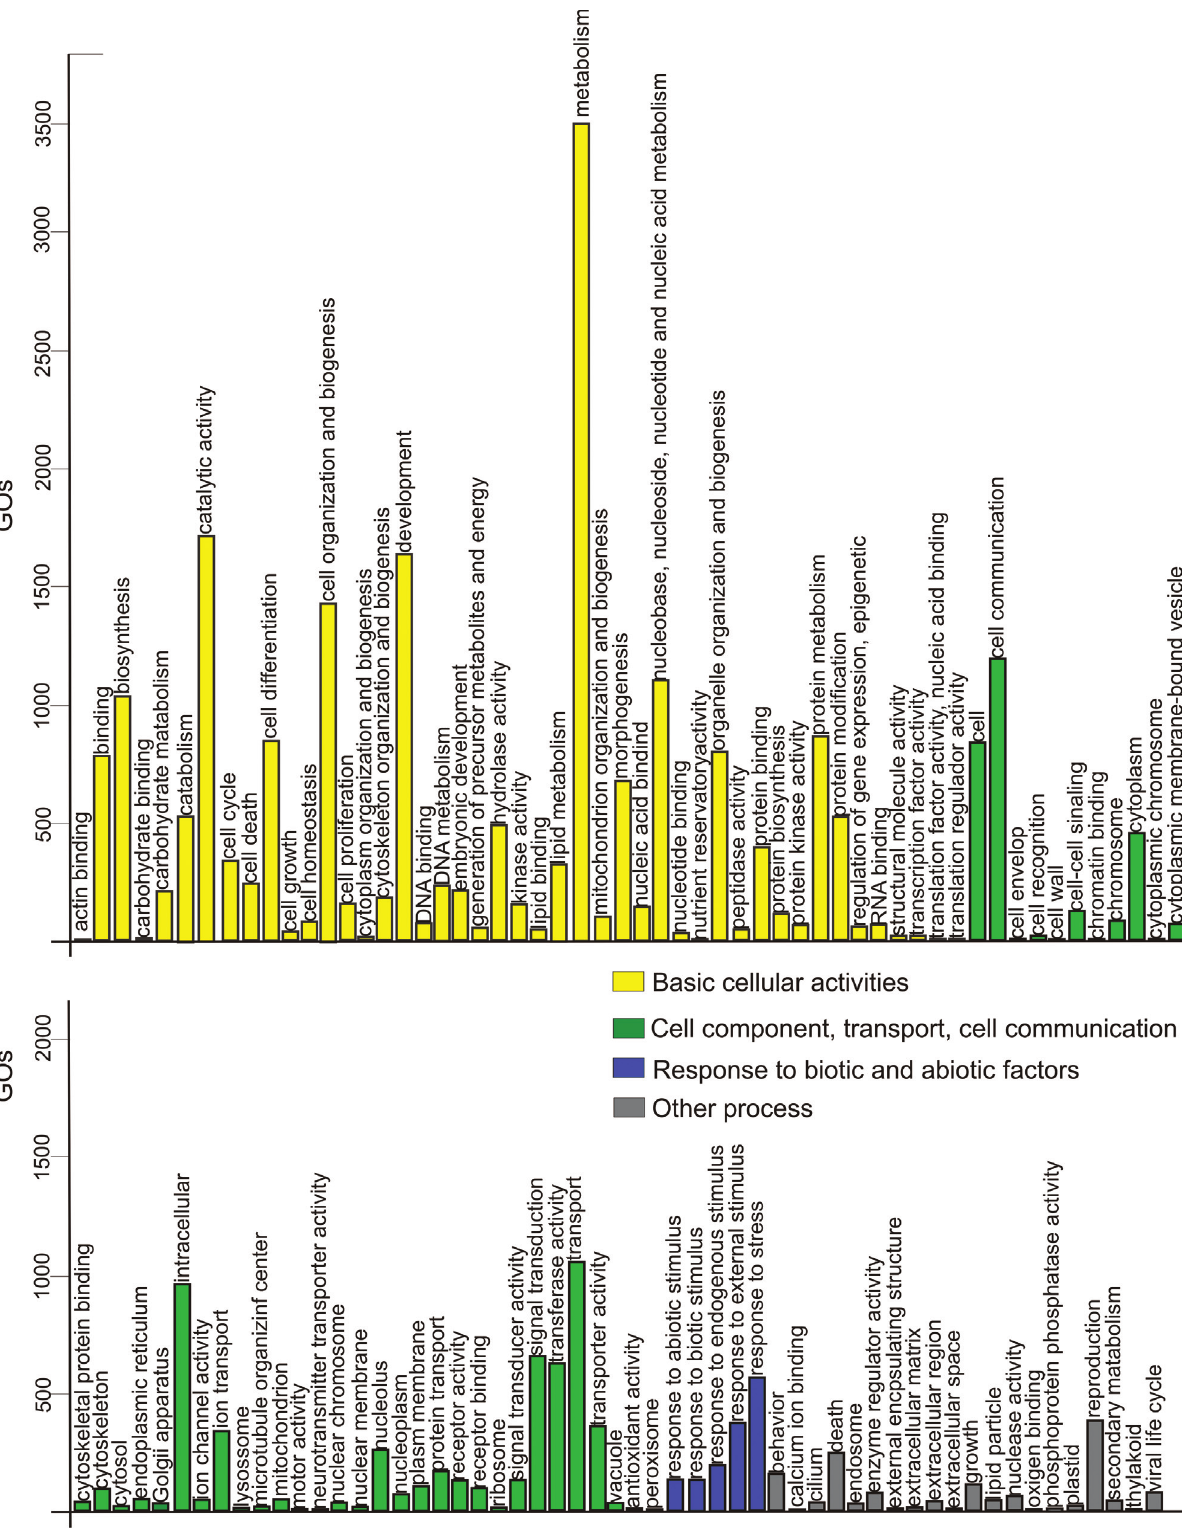
Figure 1 - GO slim terms distribution associated with the N. cinerea